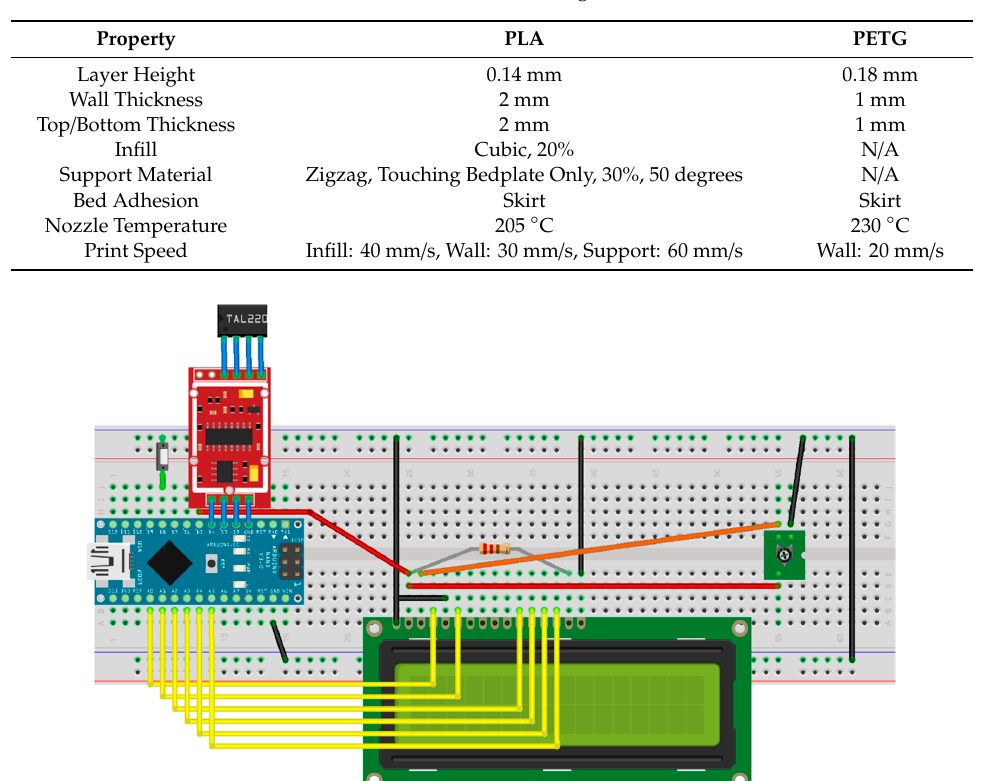
( b ) Figure 3. The circuit was assembled on a solder circuit board using jumper wires and header pins. The female header pins connect to the Arduino Nano and the HX711. The male header pins connect to the load cell and the LCD. The tare push-button is attached via twisted pair to allow installation on the face of the scale. (a) The soldered components were arranged in such a way to minimize wire use and to properly place the Arduino when installed in the base. (b) Shows the final circuit board. The 3-D printed base has several features to aid in assembly (Figure 4). The assembled circuit board was fit into the 3-D printed base—the base has bosses on the right side (facing the front) that